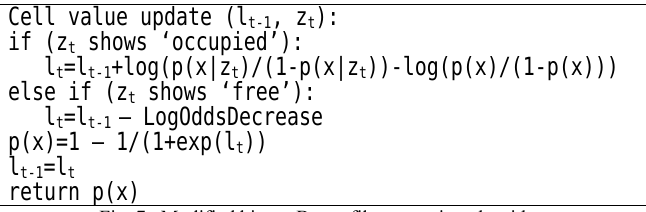
Fig. 7. Modified binary Bayes filter mapping algorithm